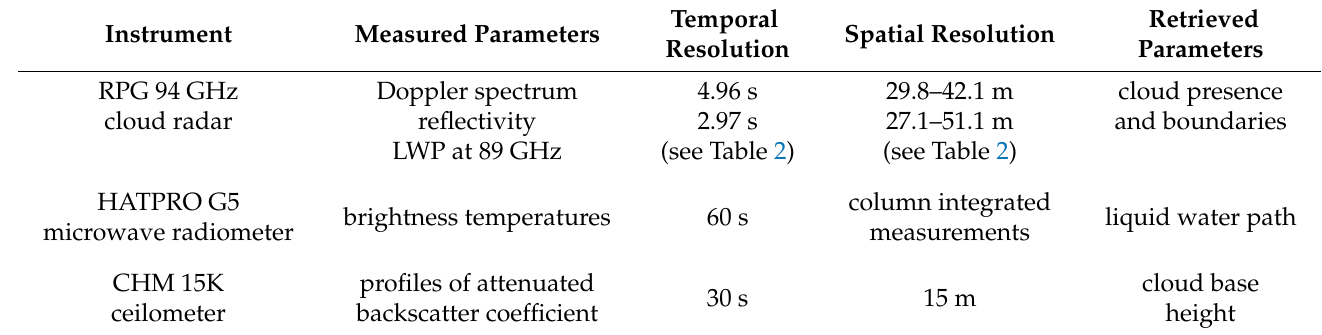
Figure 2. Instruments installed at the M˘agurele Centre for Atmosphere and Radiation studies (MARS) used in this study: ( a ) 94 GHz RPG cloud radar, ( b ) HATPRO radiometer, and ( c ) CHM15k ceilometer. Table 1. MARS instrument setup for the study